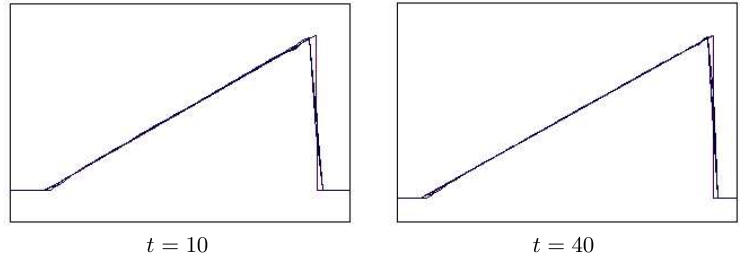
Figure 10. Numerical solution for the jumping advection method for 5 initial data ( (cid:13) = 0 : 5; 0 : 9 )